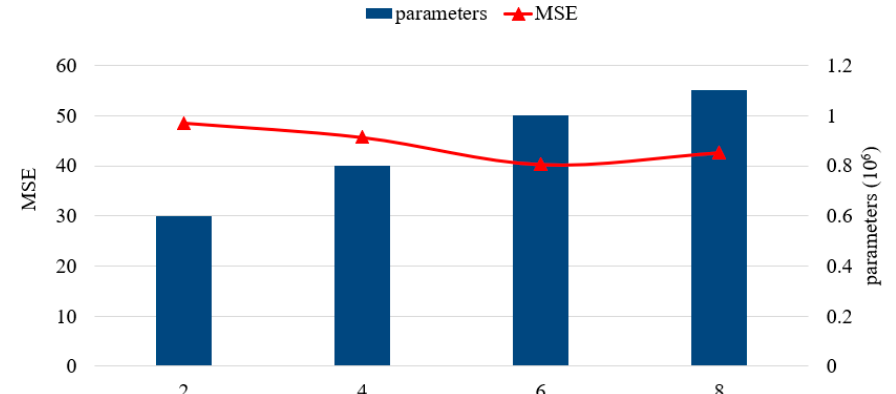
Figure 5. Number of residual units.